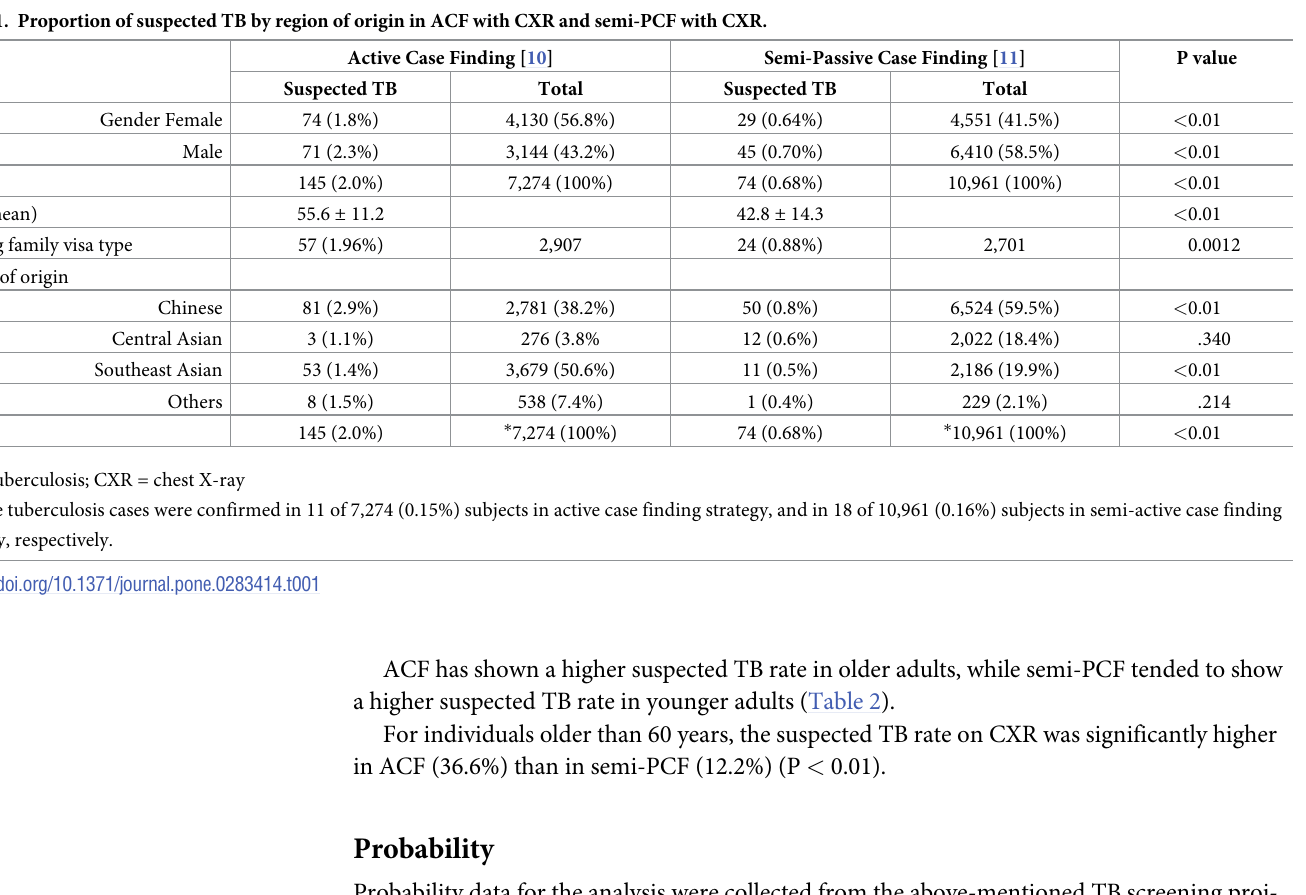
Table 1. Proportion of suspected TB by region of origin in ACF with CXR and semi-PCF with CXR.